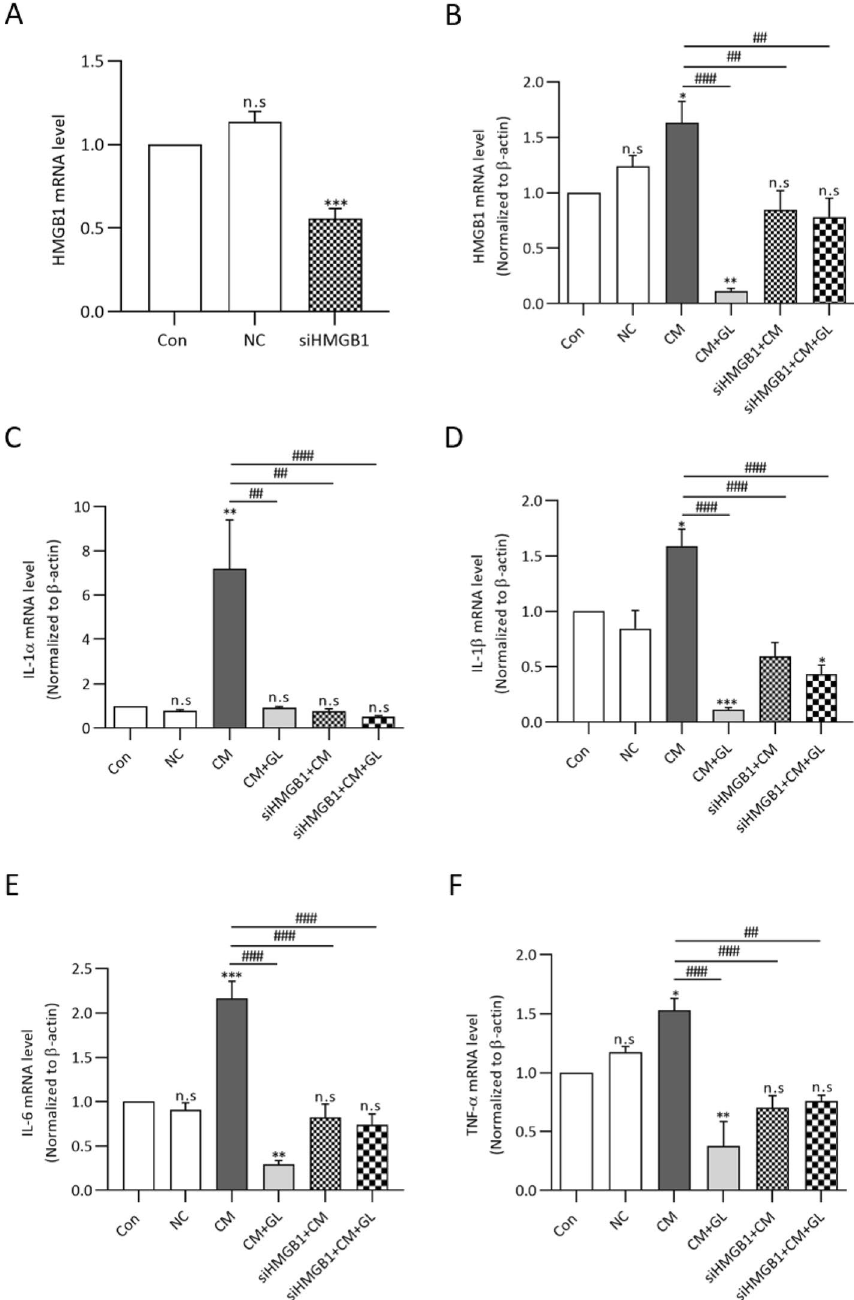
Figure 8. Knocking down HMGB1 inhibits the mRNA expression of HMGB1 and pro-inflammatory cytokines after contrast media exposure. (A) Knocking down HMGB1 inhibits the mRNA expression of HMGB1 compared to the controls and negative control. (B-F) The mRNA expression of HMGB1 and all of the pro- inflammatory cytokines did not significantly increase after cells were exposed to contrast media or contrast media + glycyrrhizin after knocking down HMGB1. (C-F). Results were expressed as means ± SEMs of three independent experiments, which were each performed in duplicate. Statistical significance: * P < 0.05, ** P < 0.01 and *** P < 0.001 Con vs CM and Con vs CM + GL, Con vs siHMGB1 ## P < 0.01 and ### P < 0.001, CM vs CM +